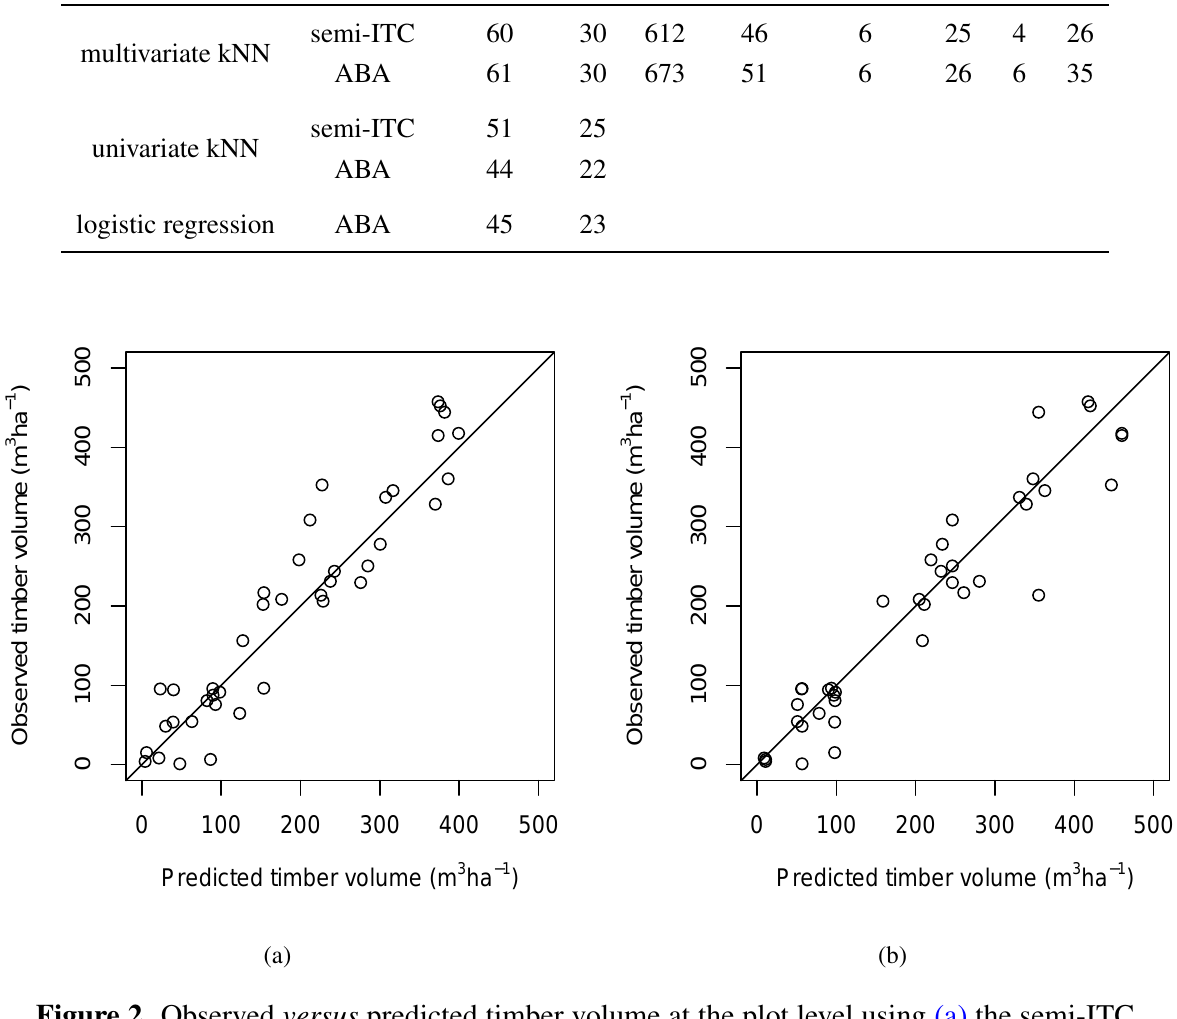
Figure 2. Observed versus predicted timber volume at the plot level using (a) the semi-ITC approach and (b) the